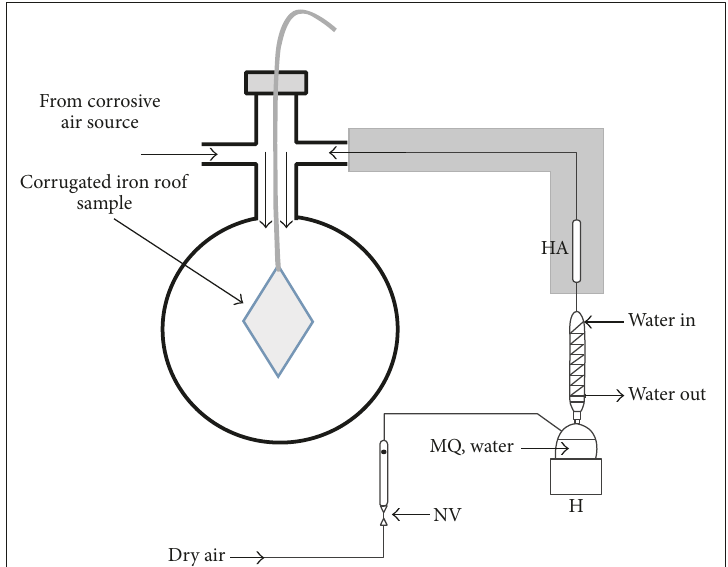
Scheme 2: Schematic experimental set-up to exposure of corrugated iron roof to simulated atmospheric condition (HA = humid air; NV =